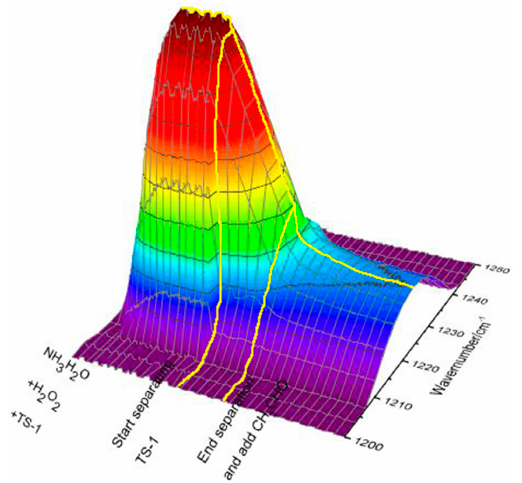
Figure 5. The change of the peak value of hydroxylamine in the entire process of the design experiment, including the separation step of the catalyst.